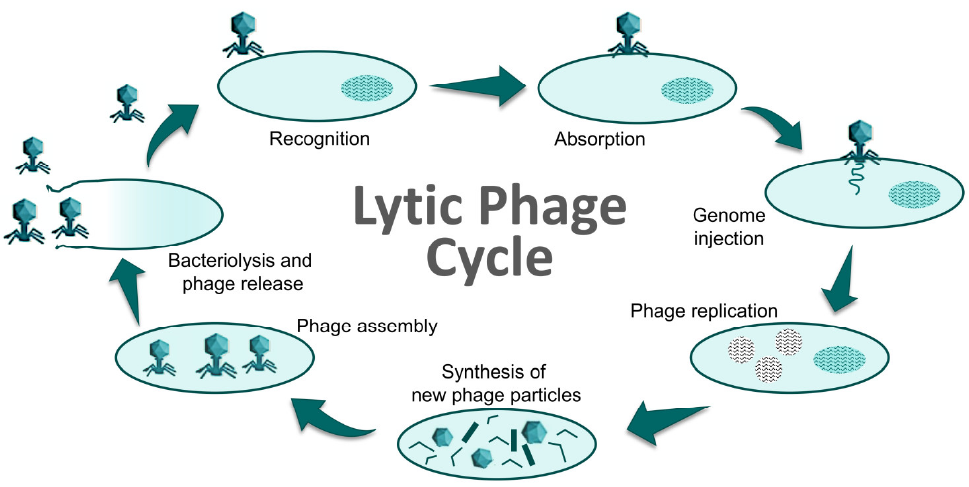
Figure 2. Cycle of a lytic phage resulting in cell death (bacteriolysis). Adapted from [20].